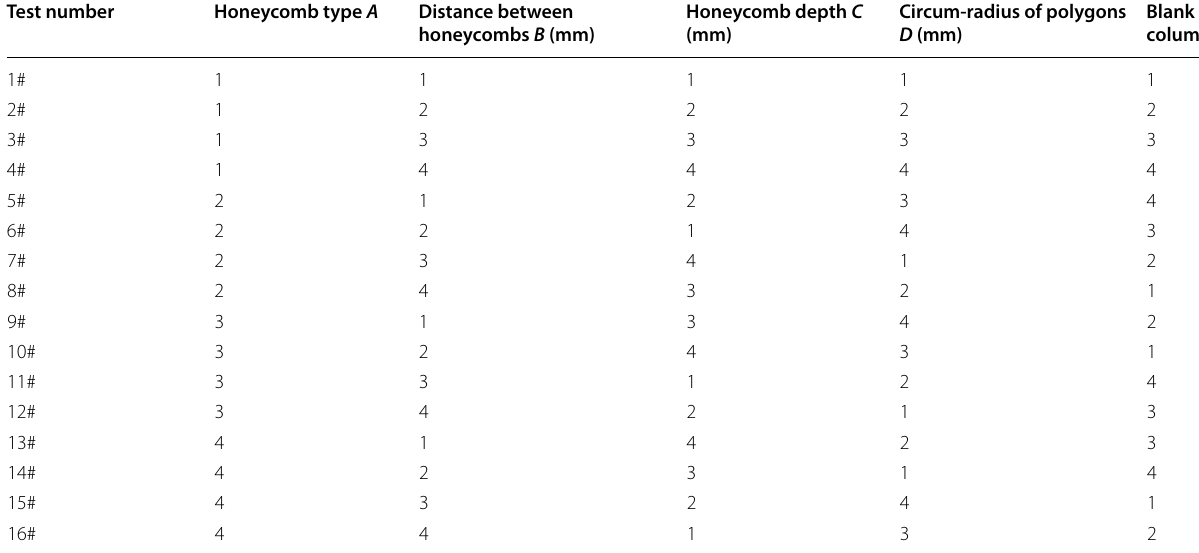
Table 2 Orthogonal array of L16 (4 5 )